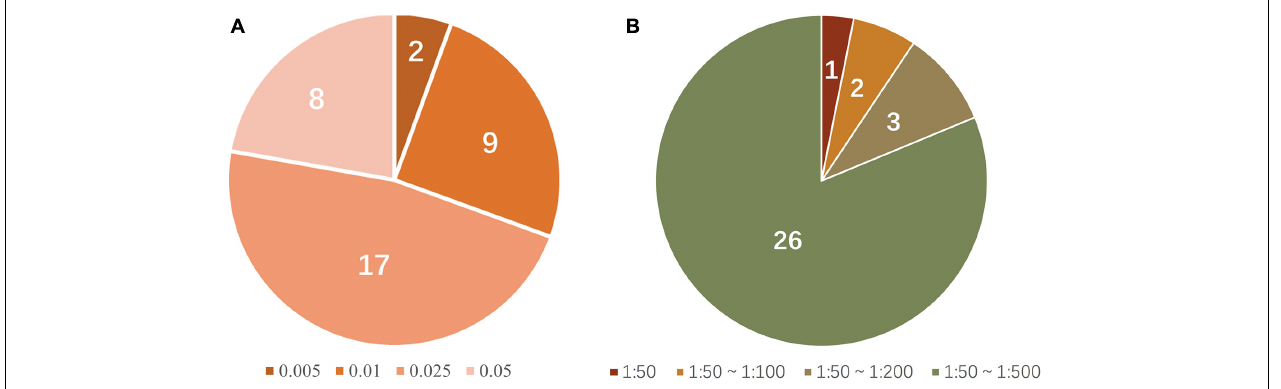
FIGURE 5 | (A) Proportion of allele-specific primer sensitivity (peak height threshold: 50 RFU); numerals in the pie chart represent the number of primers matching the condition; colors represent the corresponding minimum amount of template required. (B) Proportion of mixture detection capacity of allele-specific primers (peak height threshold: 50 RFU); numerals in the pie chart represent the number of primers matching the condition; colors represent the range of the corresponding ratios of detectable mixtures. TABLE 3 | SNP information and the probabilities of informative genotypes ( I ) for each informative genotype combination in 113 Chinese Han individuals. SNP-STR SNP minor allele Obs. Min-F